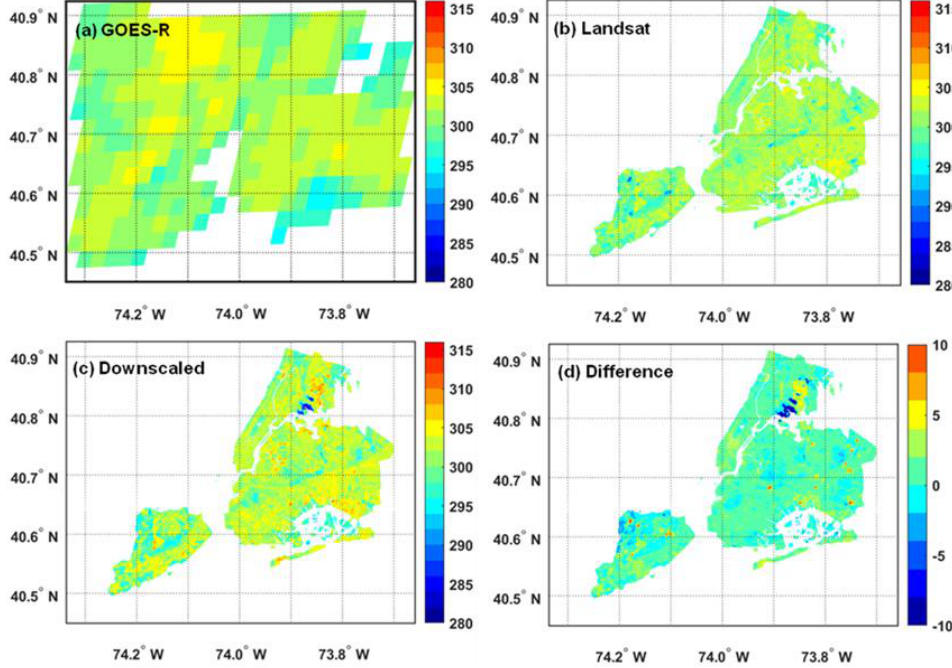
Figure 4. Spatial distributions of LST from ( a ) GOES–R, ( b ) Landsat–8, ( c ) SDM, and ( d ) difference between SDM and Landsat–8 over New York City for 31 August 2017.